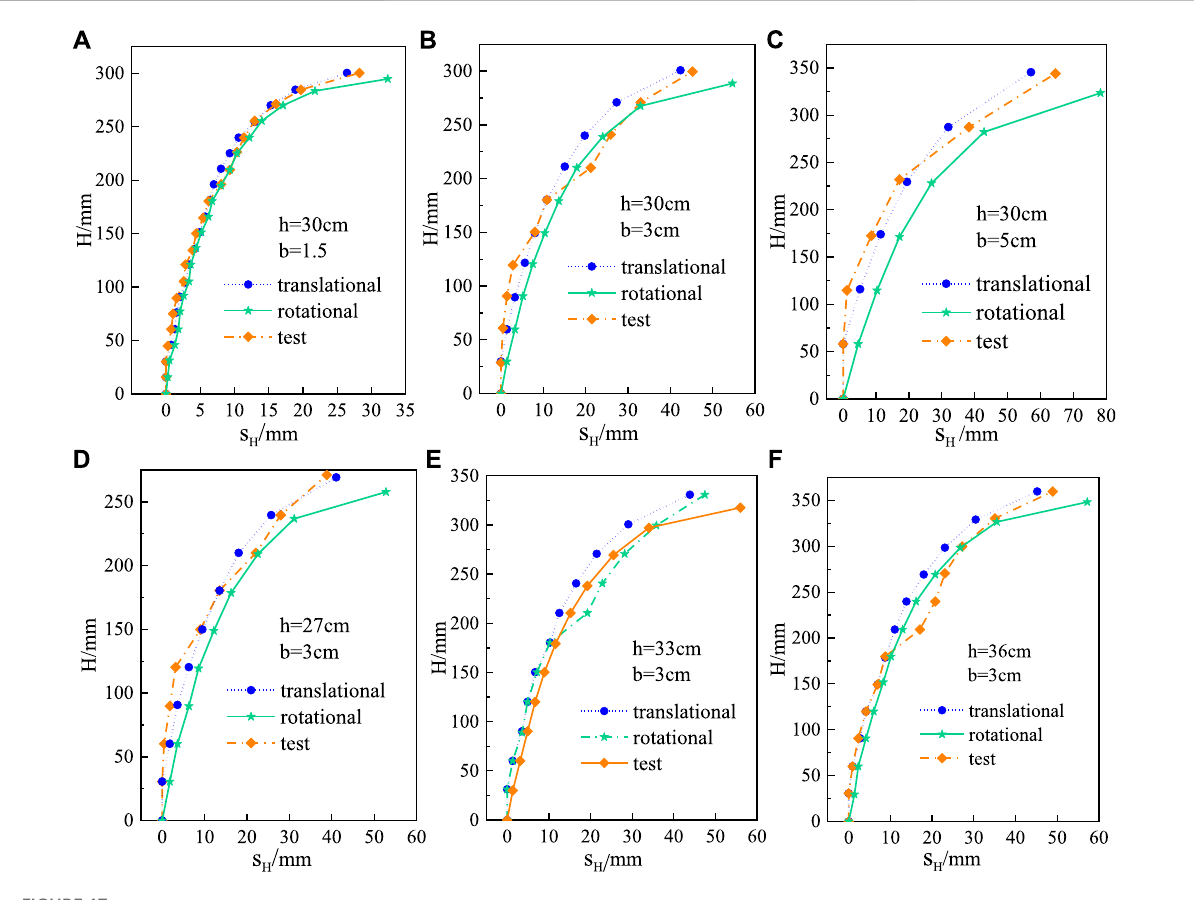
FIGURE 17 Comparison results ofbetweenmodelexperimentaland analytical solutions. (A) h =30 cm; b =1.5 cm. (B) h =30 cm; b =3 cm. (C) h = 30 cm; b = 5 cm. (D) h = 27 cm; b = 3 cm. (E) h = 33 cm; b = 3 cm. (F) h = 36 cm; b = 3